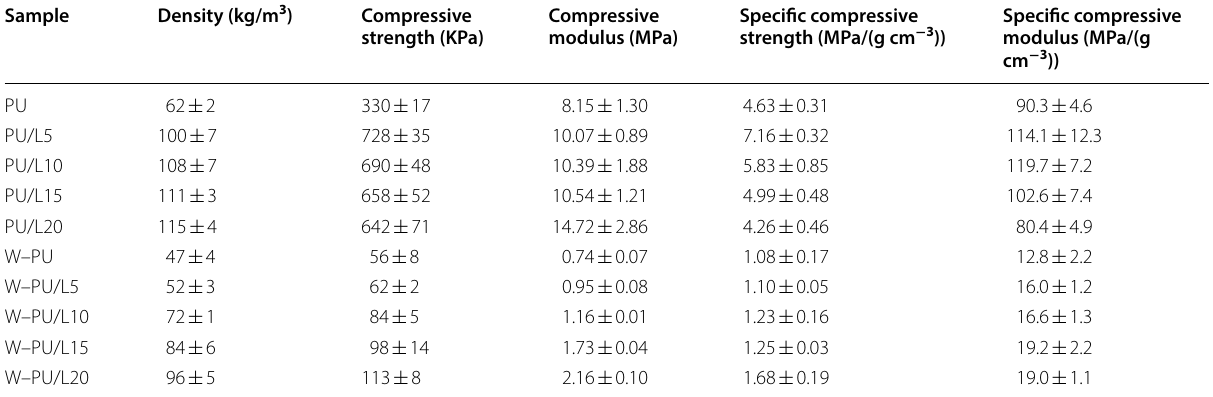
Table 3 Density and compressive properties of the PU and W–PU foams containing varying contents of lignin perpendicular to foam